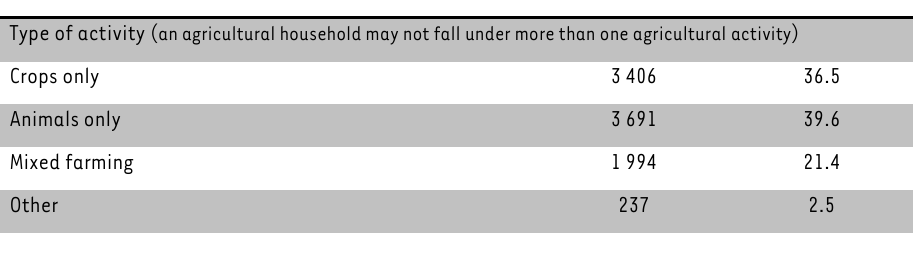
TABLE 3: Activities of Agricultural Households in uMshwathi Type of activity (an agricultural household may not fall under more than one agricultural activity)